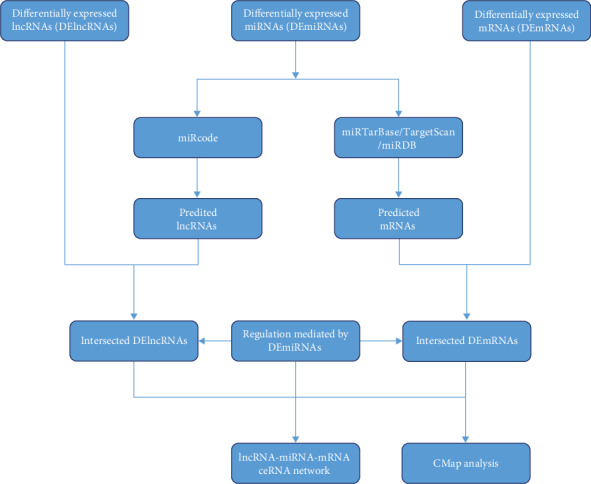
Flowchart of the lncRNA-miRNA-mRNA ceRNA network analysis.